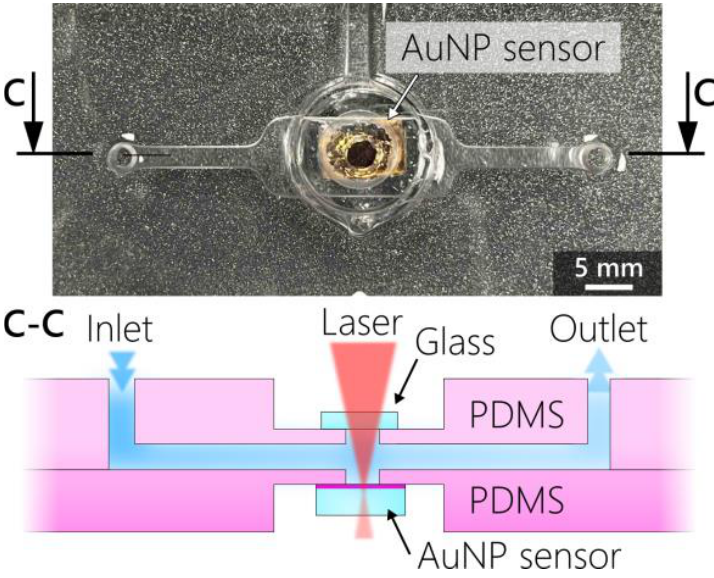
Figure 3. Photograph of the assembled microfluidic chip with the SERS substrate in the middle with a schematic cross-sectional illustration of the microfluidic cell in the bottom.